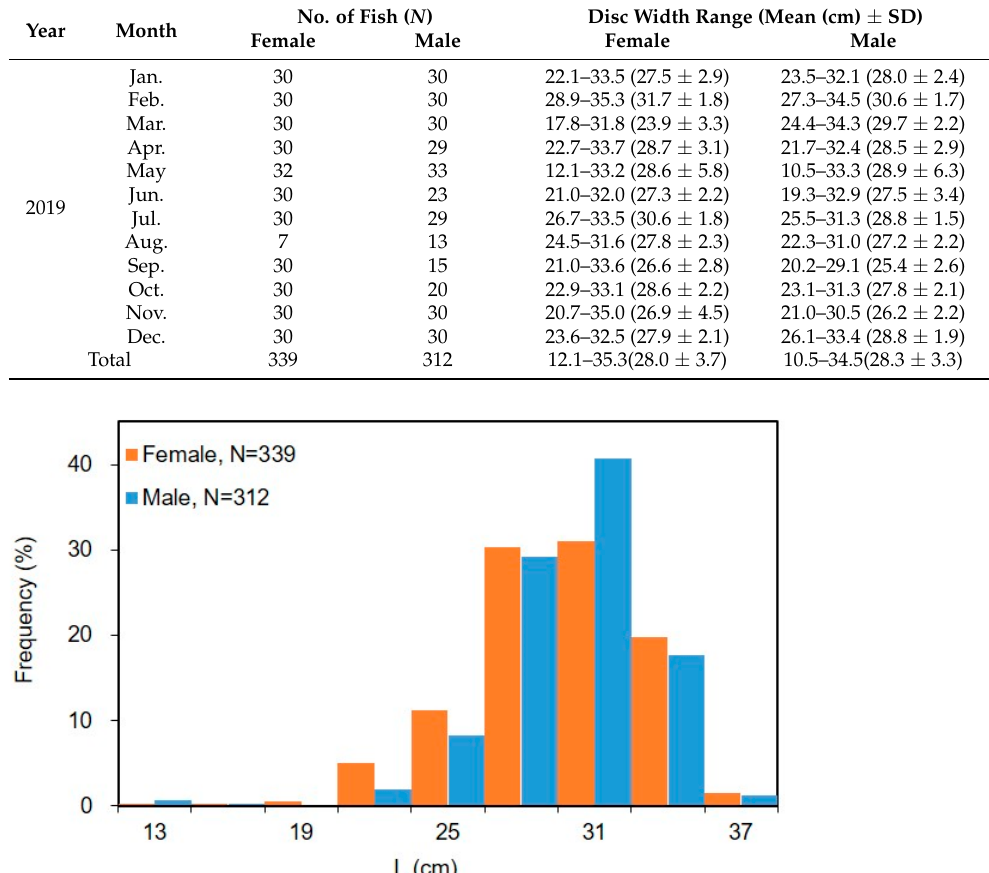
Table 1. Number and size (disc width) of ocellate spot skate ( Okamejei kenojei ) individuals collected from the West Sea of South Korea throughout 2019.